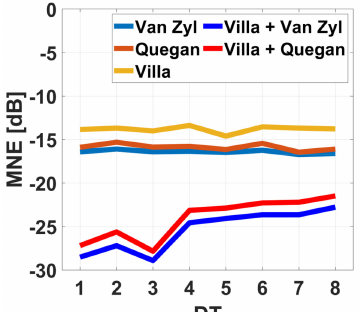
Figure 13. Maximum normalized error (MNE) of each method and the combined methods over the selected DT for the calibrated